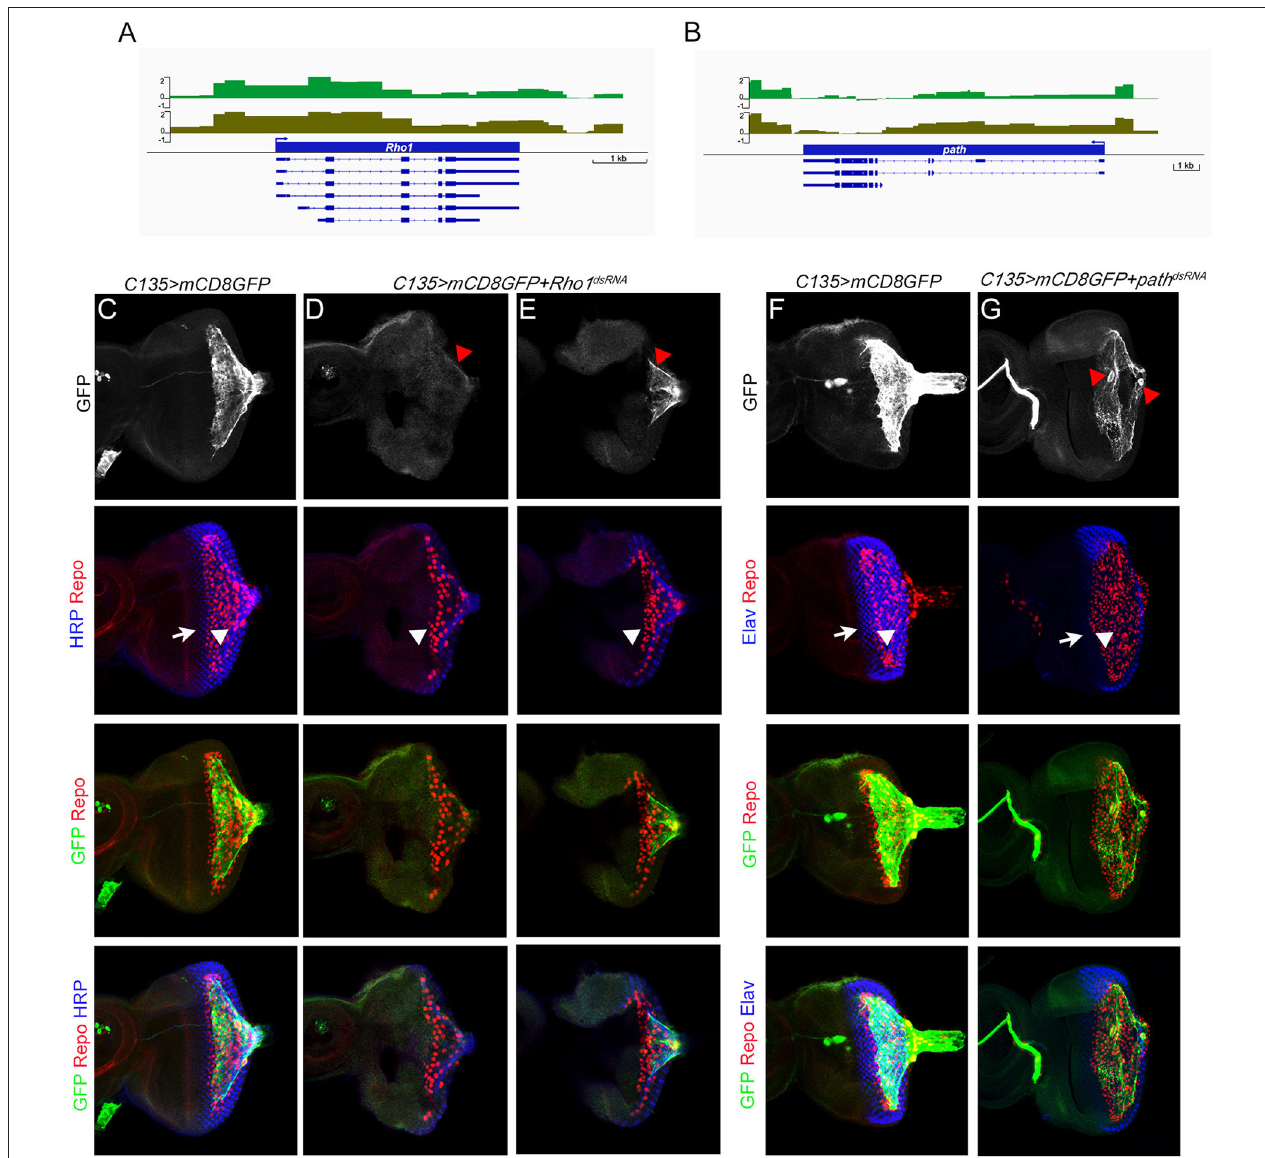
FIGURE 4 | Characterization of Dam-Pol II-bound genes: Rho1 and path . (A,B) Dam-Pol II occupancy in the Rho1 (A) and path (B) loci. Both biological replicates are shown in light and dark green. Scale bars on the y -axis represent the log 2 ratio change between Dam-Pol II and Dam samples. (C–E) All discs stained for the presence of carpet glia membrane (GFP staining, green), glial nuclei (Repo staining, red), and neuronal membrane (HRP staining, blue). (F,G) All discs stained for the presence of carpet glia membrane (GFP staining, green), glial nuclei (Repo staining, red), and differentiated PRs (Elav staining, blue). (C–G) The first row shows the membrane of carpet glia stained with GFP. Red arrowheads in (D,E) indicate the remaining membrane, and red arrowheads in (G) indicate the nuclei of carpet glia. The second row shows the relative position of the front of the PRs and that of the glia stained with HRP (C–E) /Elav (F,G) and Repo and indicated by white arrows and arrowheads, respectively. The third row shows the merged staining of Repo and GFP for the relative position between RBGs and the front of the carpet glial membrane, and the fourth row shows images merged with all staining. All images are z-projection of confocal